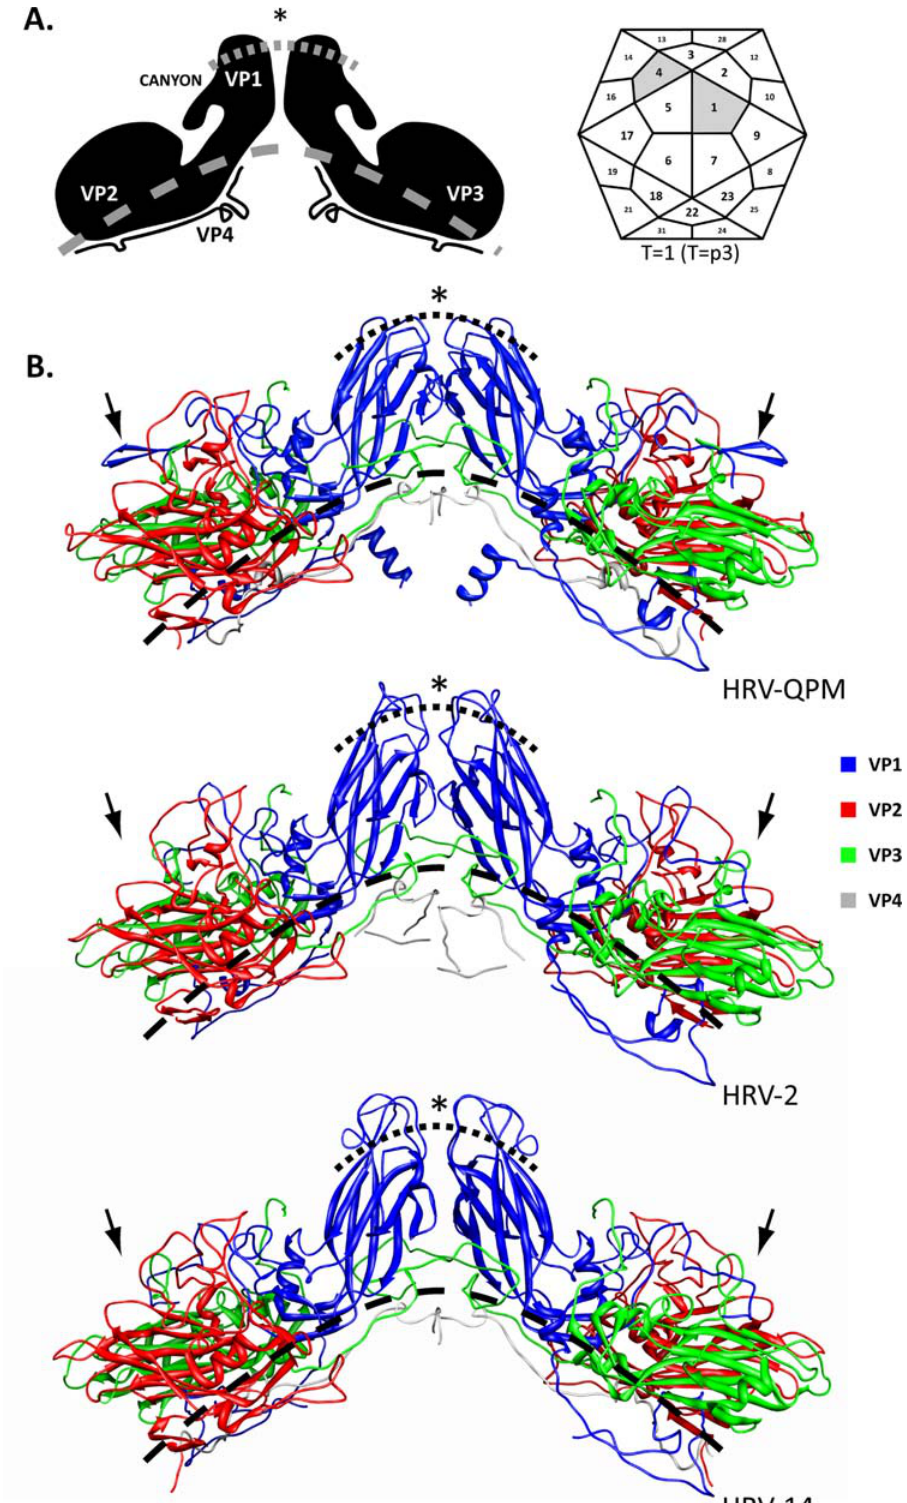
Figure 2. Comparison of predicted protomers. (A) A simplified depiction of two protomers in opposition on a viral capsid (shaded areas, adapted from [37]). As a guide for visualising loop length, a dashed and a dotted line are spaced equidistantly and represent proximal and distal positions from the virion core, respectively. (B) Ribbon depiction of two opposing viral protomers from HRV-QPM, HRV-2 (minor group) and HRV-14 (major group). HRV-QPM proteins were predicted by in silico matching to the empirically derived HRV-16 and HRV-14 structure (materials and methods). Protomers consist of one copy each of VP1, VP2, VP3 and VP4. b -sheets are depicted as flat arrows and a -helices as coiled ribbons. The formation of VP1-VP3 into eight anti-parallel b -sheets is indicative of the ‘jellyroll’ conformation typical in picornaviruses. Major differences in the predicted HRV-QPM VP1 include the shortened external loops between b -sheets (asterisk) and an additional C-terminal sheet-loop-sheet formation (arrow indicates the same location on all protomers for comparison). doi:10.1371/journal.pone.0001847.g002 PLoS ONE |